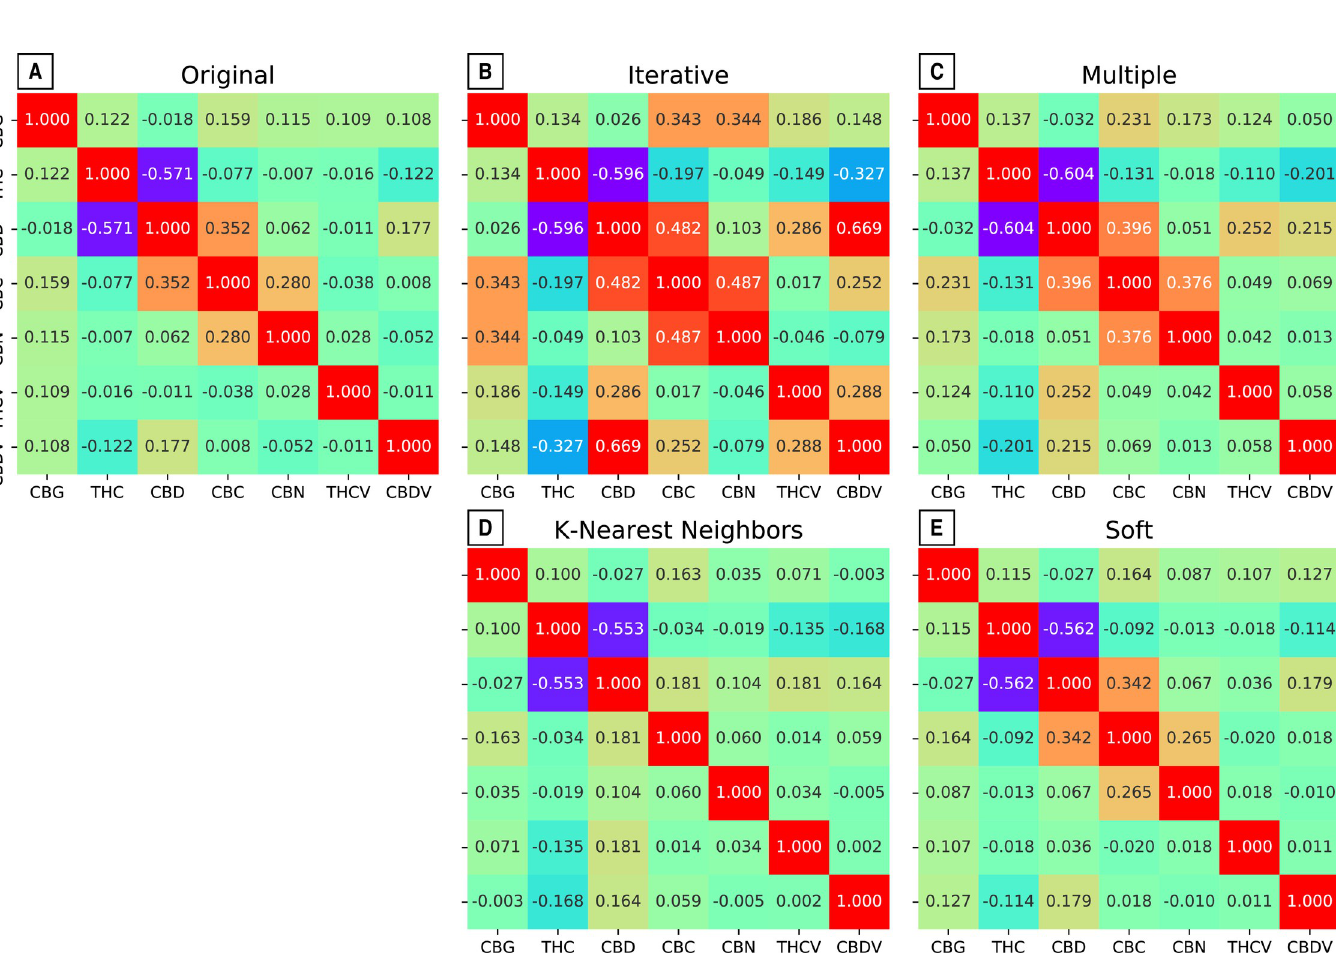
PLOS ONE | https://doi.org/10.1371/journal.pone.0236878 September 1,